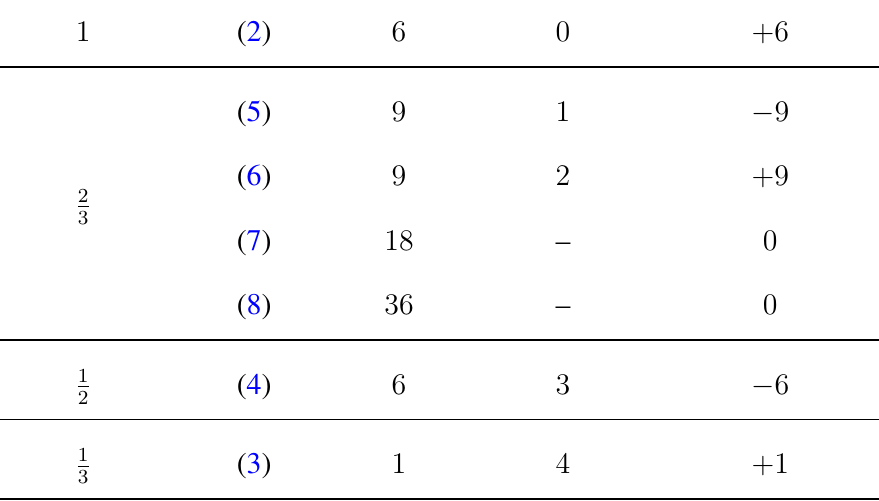
Figure 1. Summary for the Nash equilibria of a signaling game with n = 3 . The Morse index and the Poincaré index refer to the rest points of the selection-mutation dynamics in behavior strategies (14) for the case 2 ε > δ > ε . The Morse index is the number of positive 2 eigenvalues of the Jacobian. At a maximizer of the potential function, the Morse index is 0 . The Poincaré index is − 1 if the number of positive eigenvalues is odd and +1 if it is even. The sum of the Poincaré indices is 1 , which is equal to the Euler characteristic of the state space; cf . [15], Ch.